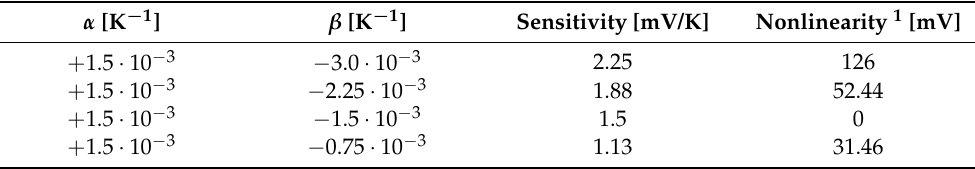
Figure 6. V sig as a function of ∆ T in different ( | α | ; | β | ) conditions for α = + 1.5 · 10 − 3 K − 1 , realistic value for n+ diffusion integrated resistors [67]. Table 3. Additional details regarding the curves of Figure